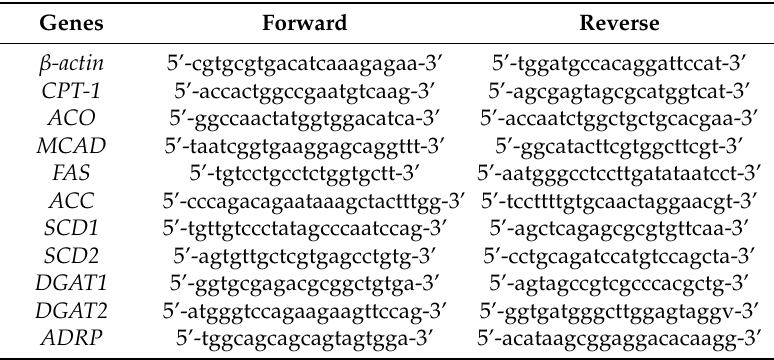
Table 2. Primer sets used in the real-time PCR